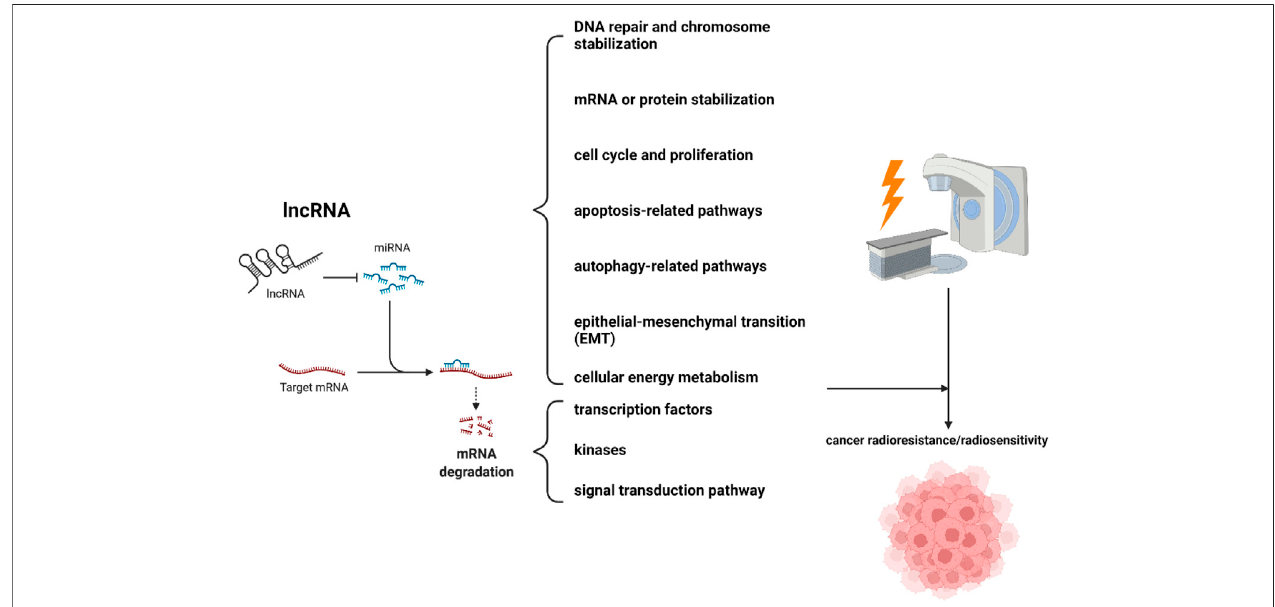
FIGURE 2 | The mechanism of lncRNAs regulating ionizing radiation via